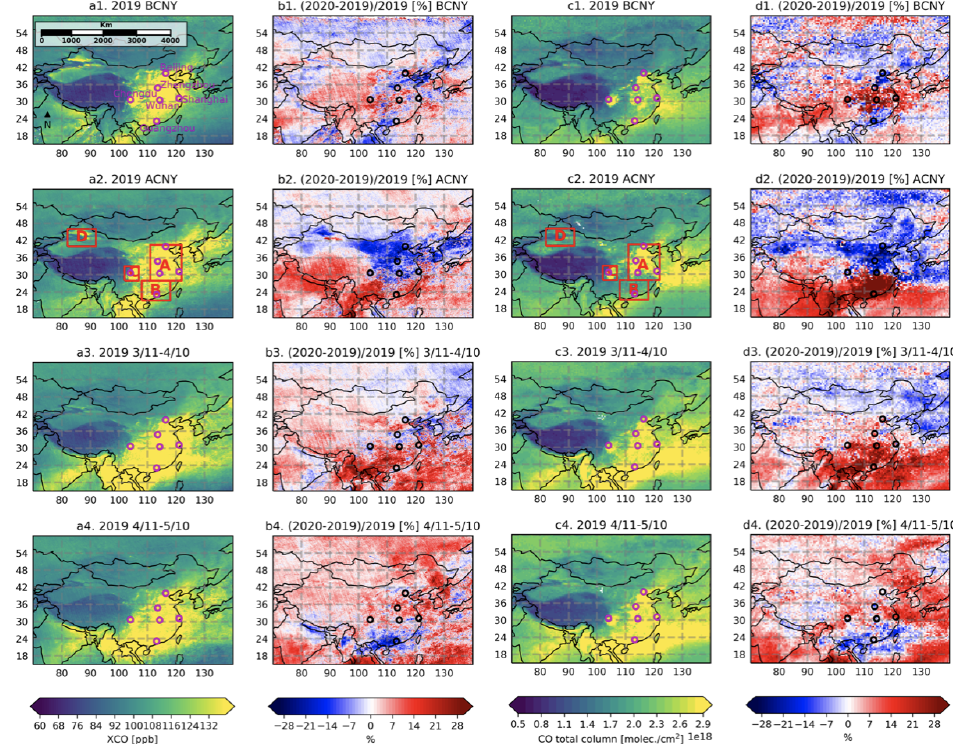
Figure 5. The TROPOspheric Monitoring Instrument (TROPOMI) satellite XCO observations in units of ppb ( a1 – a4 ) and the Infrared Atmospheric Sounding Interferometer (IASI) CO column observations in unit of molec./cm 2 ( c1 – c4 ) over China during BCNY, ACNY, 3/11–4/10, and 4/11–5/10 in 2019, together with the relative differences between 2020 and 2019 ((2020–2019)/2019 × 100%) (TROPOMI: b1 – b4 , IASI: d1 – d4 ). The six megacities are marked as the purple and black circles. The four regions are marked in ( a2 , c2